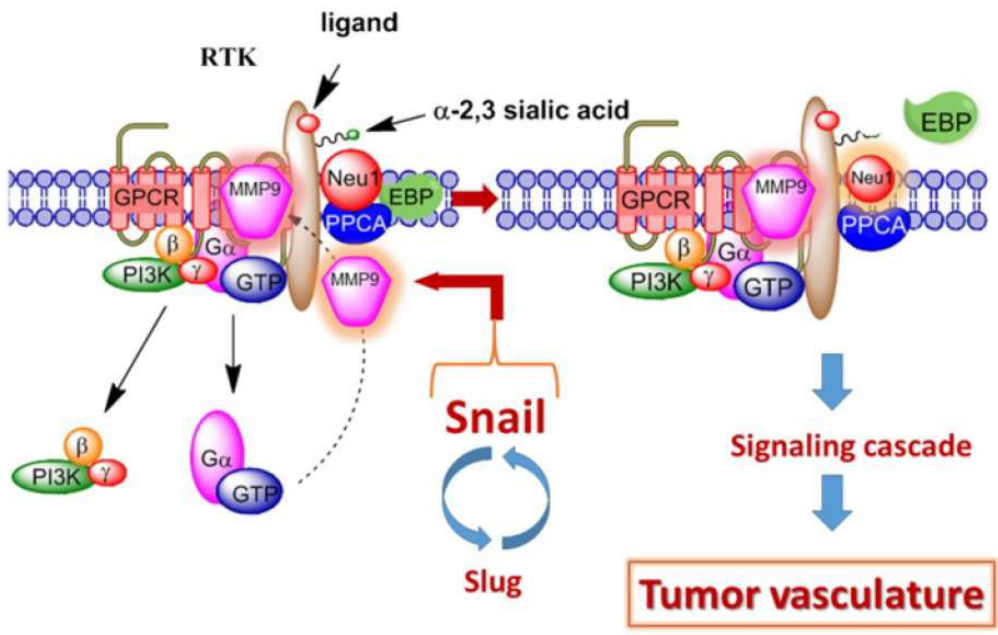
Figure 1. Snail and matrix metalloproteinase-9 (MMP-9) signaling axis in facilitating a neuraminidase-1 (Neu1) and MMP-9 crosstalk in regulating receptor tyrosine kinases (RTKs) to promote tumor neovascularization. Notes: For ovarian cancers, Snail and MMP-9 expressions are closely connected to similar invasive tumor processes. Snail induces MMP-9 secretion through oncogenic H-Ras (RasV12) and other multiple signaling pathways. Snail also leads to the transcriptional upregulation of MMP-9. This Snail-MMP-9 signaling axis is the connecting link in promoting the modification of growth-factor-receptor glycosylation involving the subsequent receptor-signaling platform of Neu1-MMP-9 crosstalk in complex with RTKs within their ectodomains. Activated MMP-9 removes the elastin-binding protein (EBP) within the molecular multienzymatic complex consisting of β-galactosidase/Neu1 and protective protein cathepsin A (PPCA). Activated Neu1 hydrolyzes α-2,3-sialic acid residues of RTKs to remove steric hindrance leading to receptor association and activation. Here, the stage for Snail’s role in tumor neovascularization is established. Abbreviations : GPCR, G-protein coupled receptor; Pi3K, phosphatidylinositol 3-kinase; GTP, guanine triphosphate. Citation: © 2014 Abdulkhalek et al. [37].